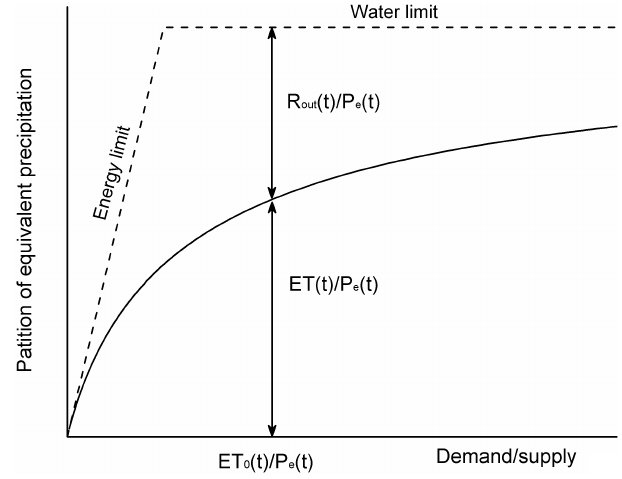
Figure 1. A schematic diagram of the BH under the unsteady-state